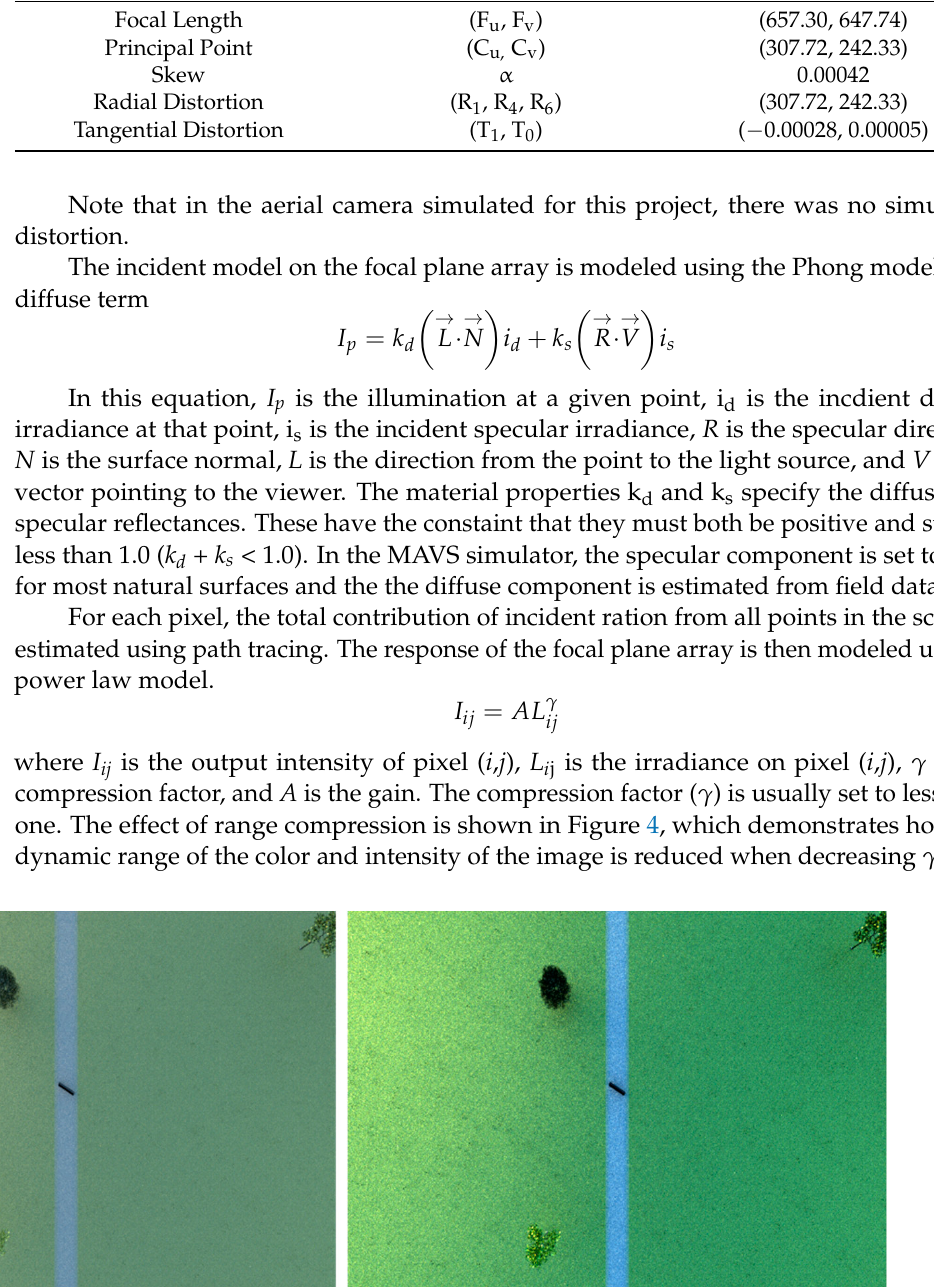
Figure 3. Example of the effect of distortion in the MAVS camera simulation. ( Left ) Distorted image. ( Right ) Undistorted image. Table 1 . Example parameters in the MAVS camera distortion model.